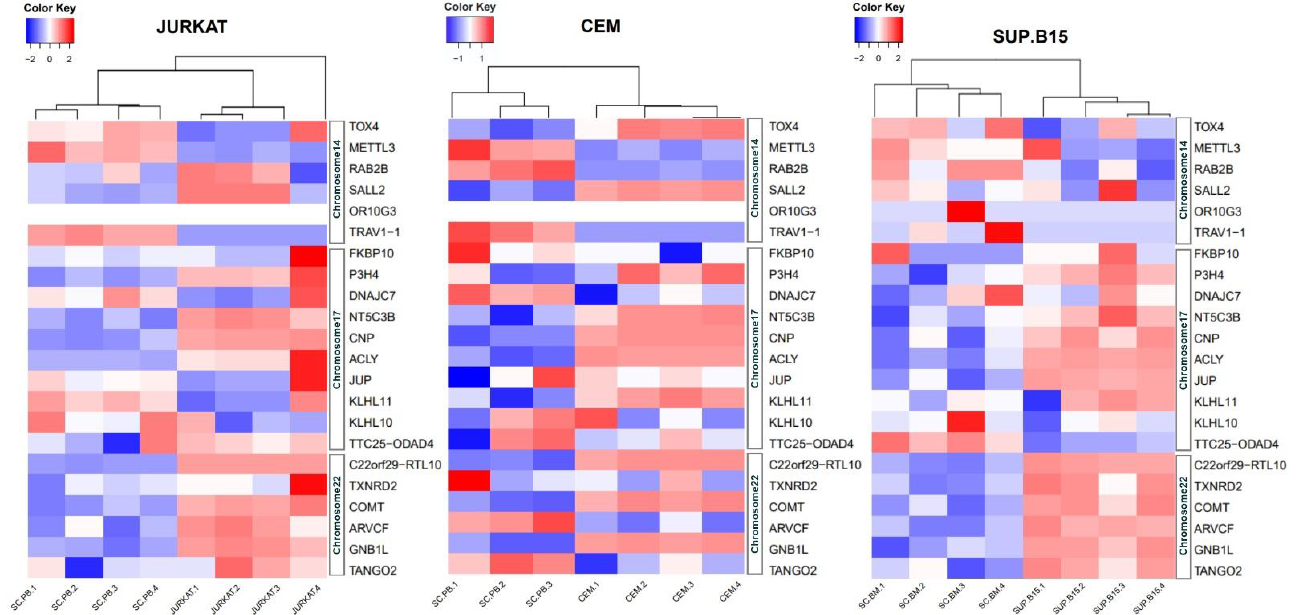
Figure 5. Normalized expression heatmaps (FPKM) of genes present in gain regions of chromosomes 14, 17, and 22 in the JURKAT, CEM, and SUP-B15 cell lines. The dendrogram depicts groups according to expression similarities. The samples included are: SC-PB — sample controls from peripheral blood; and SC-BM — sample controls from bone marrow. Data 1 – 4 in each of the cell lines represent independent sequencing; JURKAT4 and CEM4 were derived from our RNA sequencing